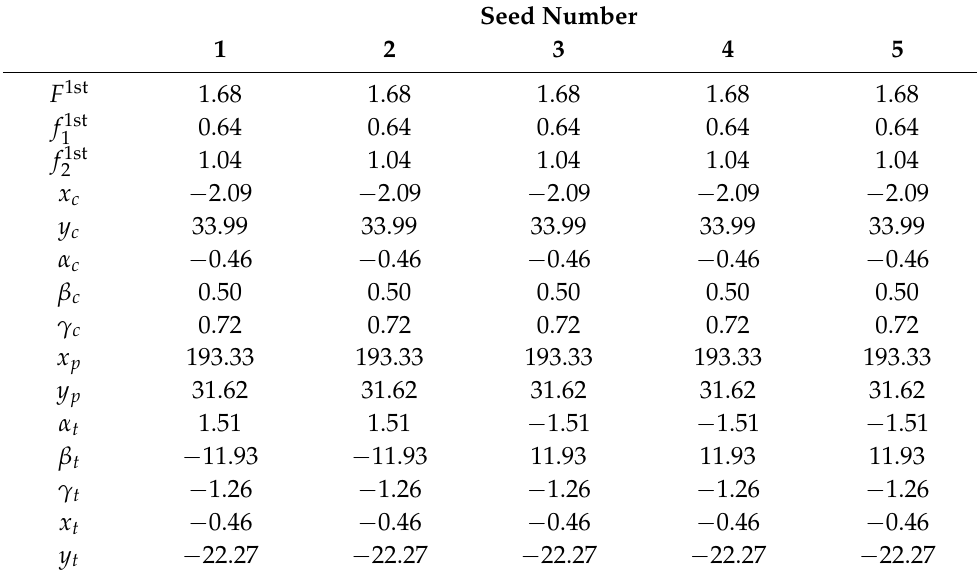
Table 7. Optimization results of the six-DoF HTMs after first-stage optimization.